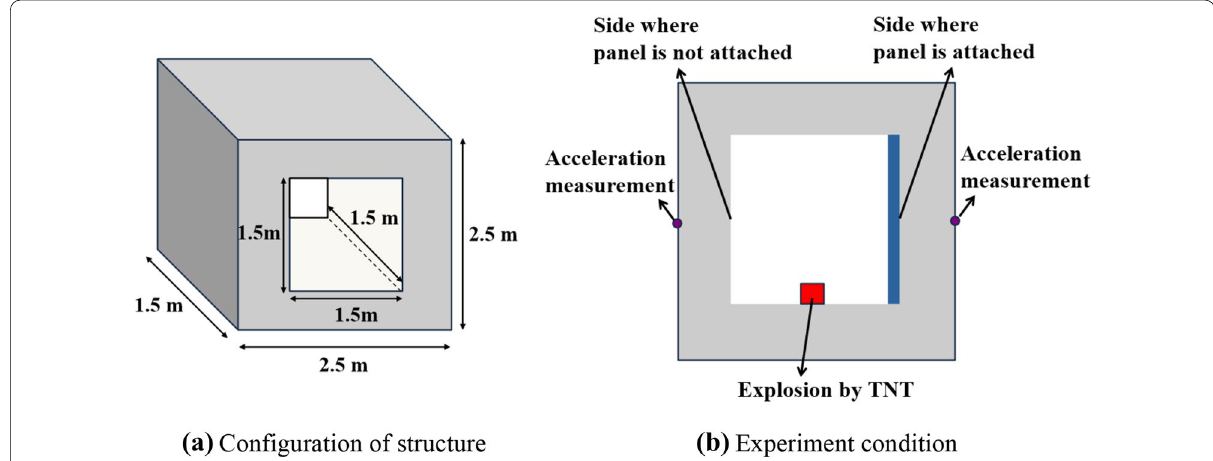
Fig. 2 Configuration and experimental condition of reinforced concrete structure.